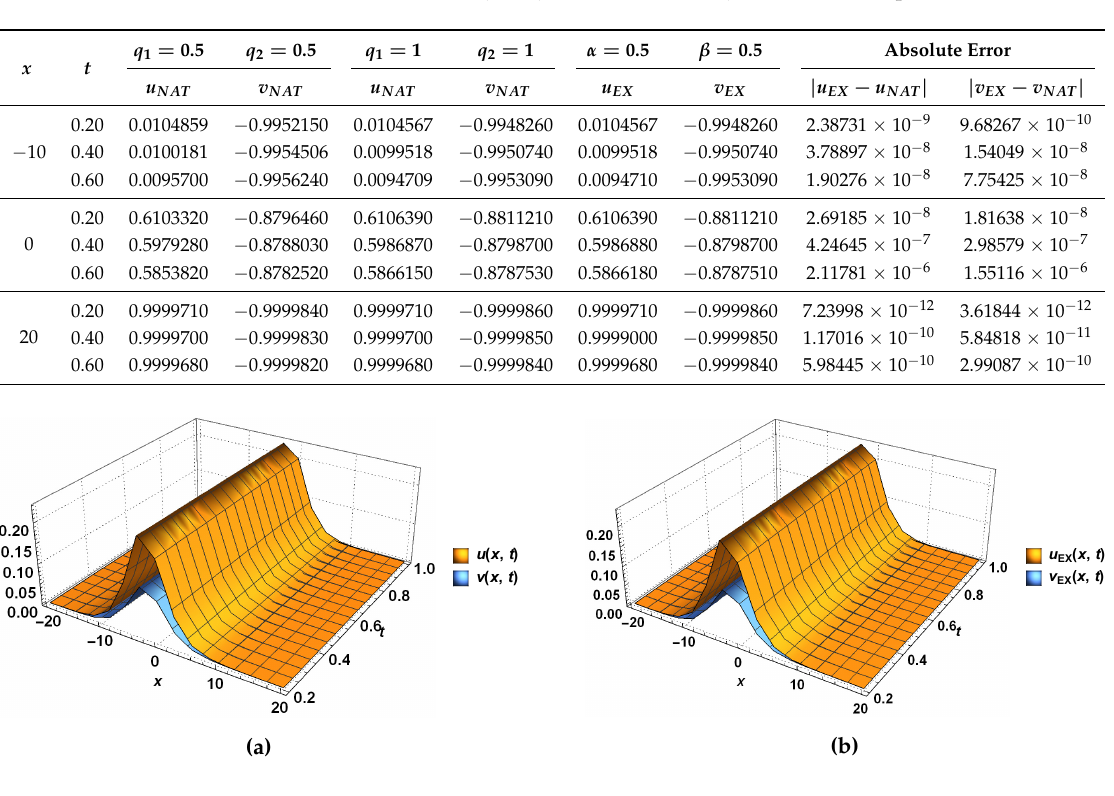
Table 2. Numerical values when q 1 = q 2 = 0.5,1 and α = β = 0.5 for Example 2.